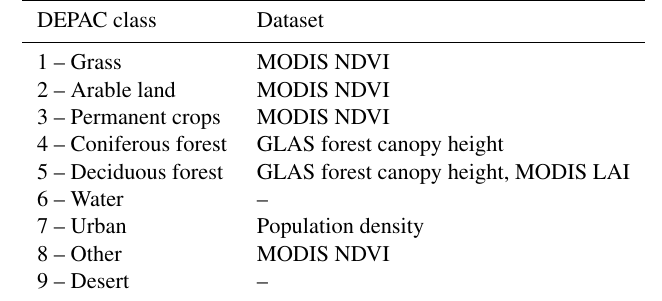
Table 2. An overview of the datasets that are used to derive z 0 input values for each DEPAC land use category.